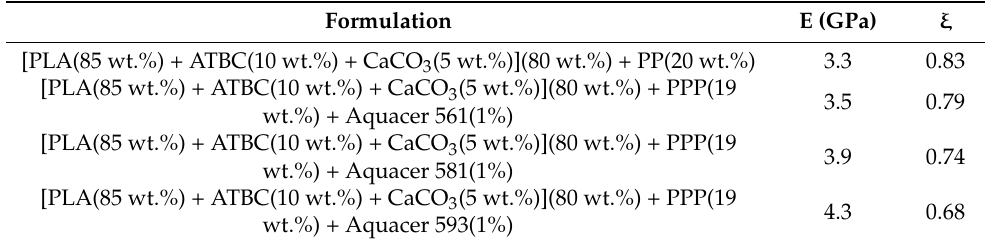
Table 5. Elastic modulus (E) and calculated adhesion parameter ( ξ ), according to the Sato and Furukawa model